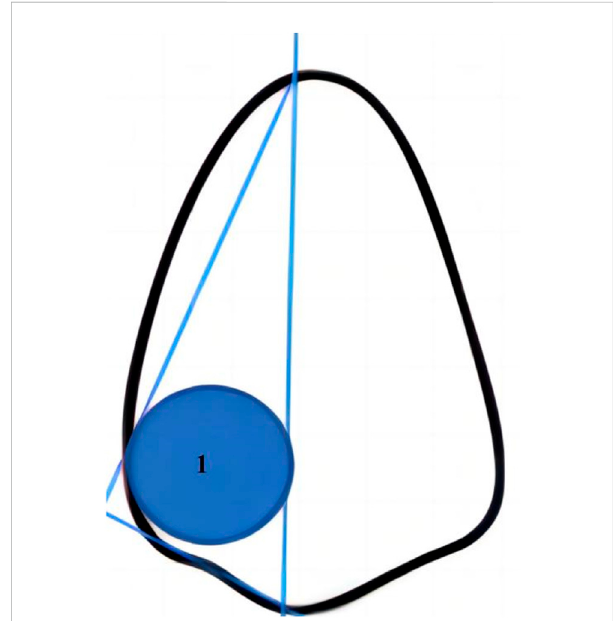
FIGURE 1 Tooth color measurement site. The blue area (1) is the color measurement site.